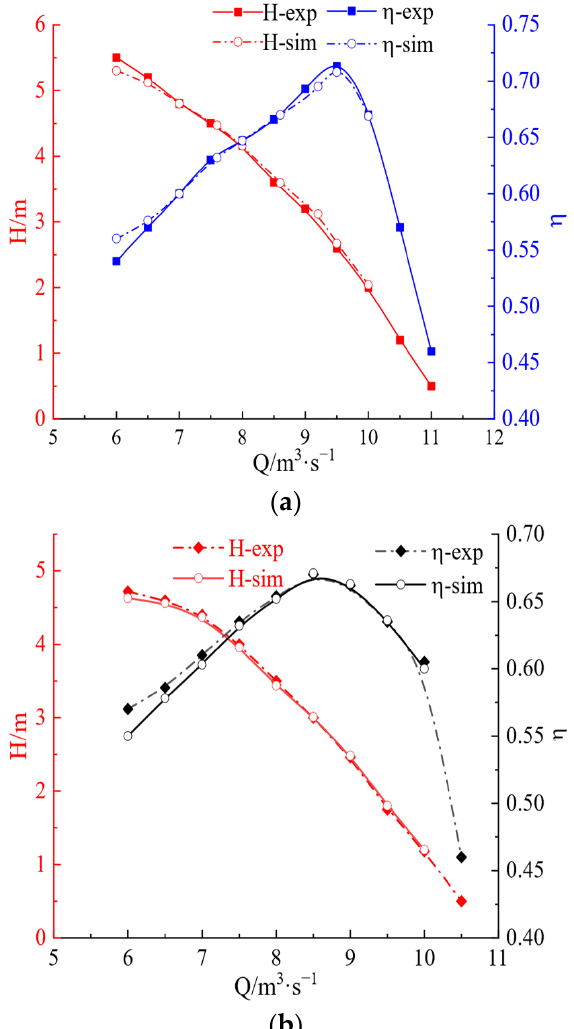
Figure 4. ( a ) Forward characteristic curve, ( b ) reverse characteristic curve.